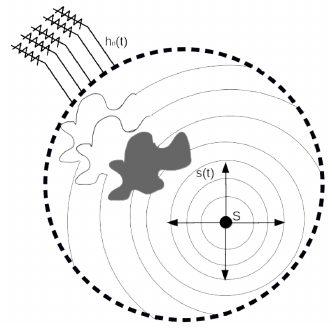
Figure 1. Transmission of the incident wave from source to sensors.